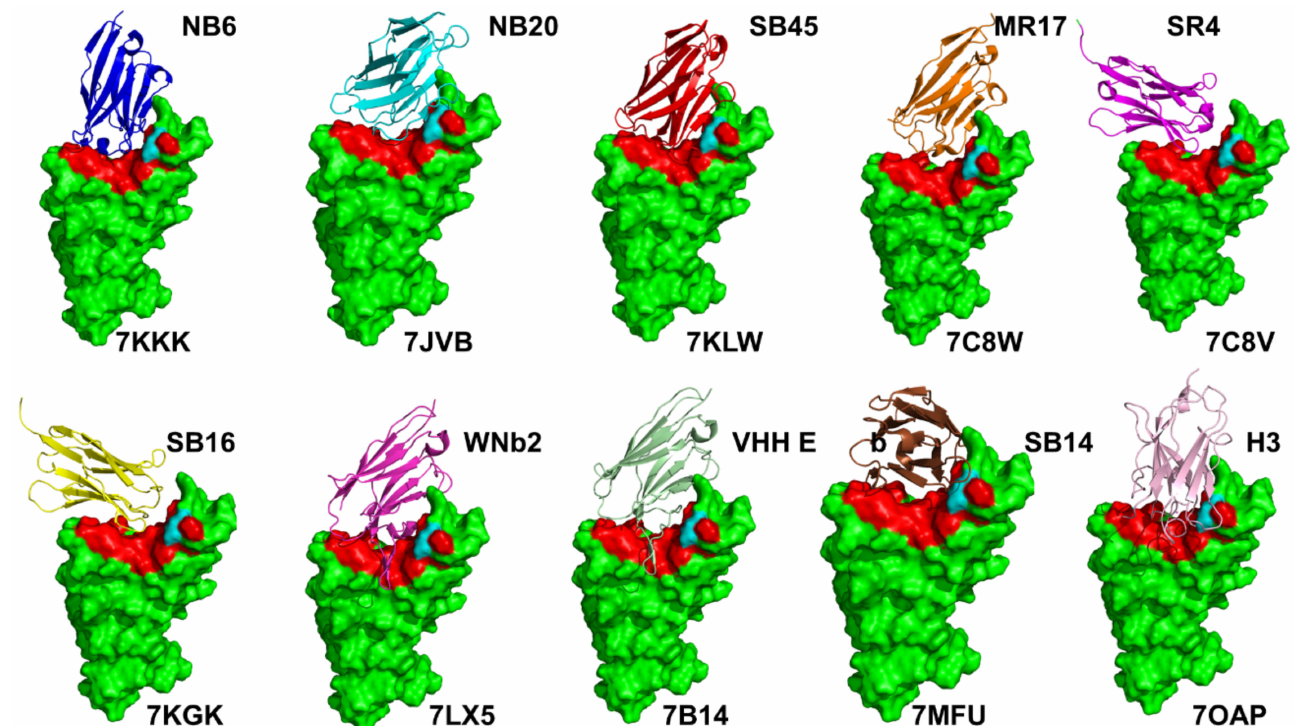
Figure 3. Structural details and binding modes for the class I nanobodies in complexes with S-RBD. The representative class I nanobodies shown are Nb6 (pdb id 7KKK), Nb20 (pdb id 7JVB), Sb45 (pdb id 7KLW), MR17 (pdb id 7C8W), SR4 (pdb id 7C8V) (top panel) and Sb16 (pdb id 7KGK), WNb2 (pdb id 7LX5), VHH-E (pdb id 7B14), Sb14 (pdb id 7MFU), and H3 (pdb id 7OAP) (bottom panel). The S-RBD is shown in green surface. The nanobodies are shown in ribbons. A typical binding epitope for this class is shown in red-colored surface. A high degree of similarity in binding modes can be seen for Nb6, Nb20, Sb45, MR17, WNb2, and VHH-E. A highly unusual binding mode was observed for SR4 and Sb16. The unique binding modes are seen for Sb14 and